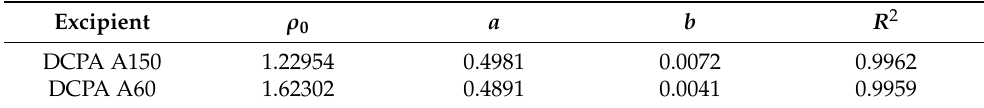
Table 4. Coefficients for the Kawakita model.